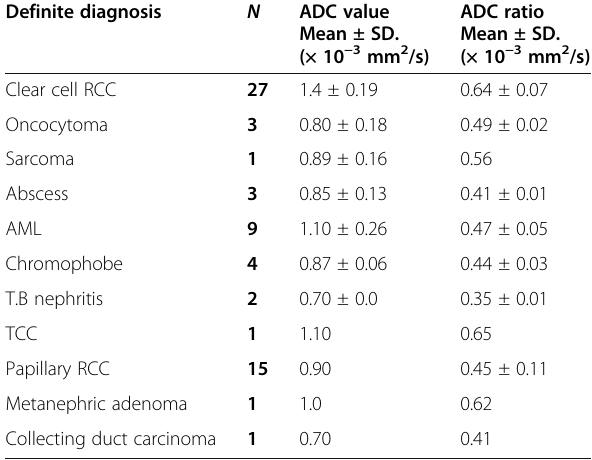
Table 4 Mean ADC value and ADC ratio for different masses (